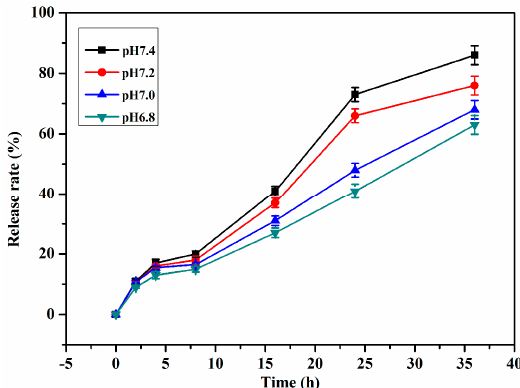
Figure 3. Release of ellagic acid from β -CD-ellagic acid microspheres at pH 7.4, 7.2, 7.0, 6.8. Table 1. Effect of ellagic acid microspheres on HepG2 cell proliferation.